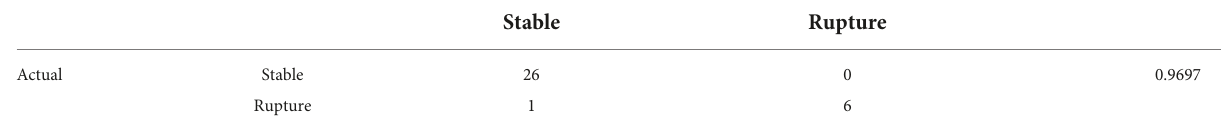
TABLE 3 The predictive ability of XGBoost model in the testing